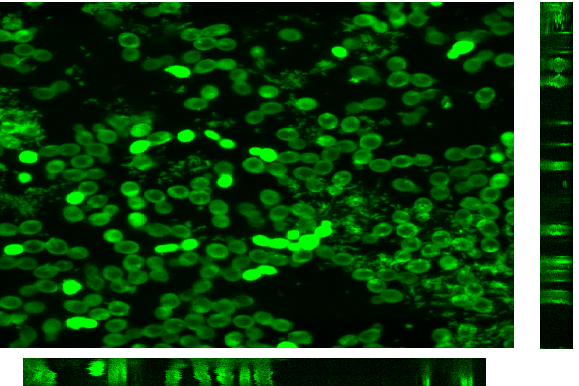
Figure 12. Orthogonal view of the 3D reconstruction of a 0.45 µm microsieve fouled by